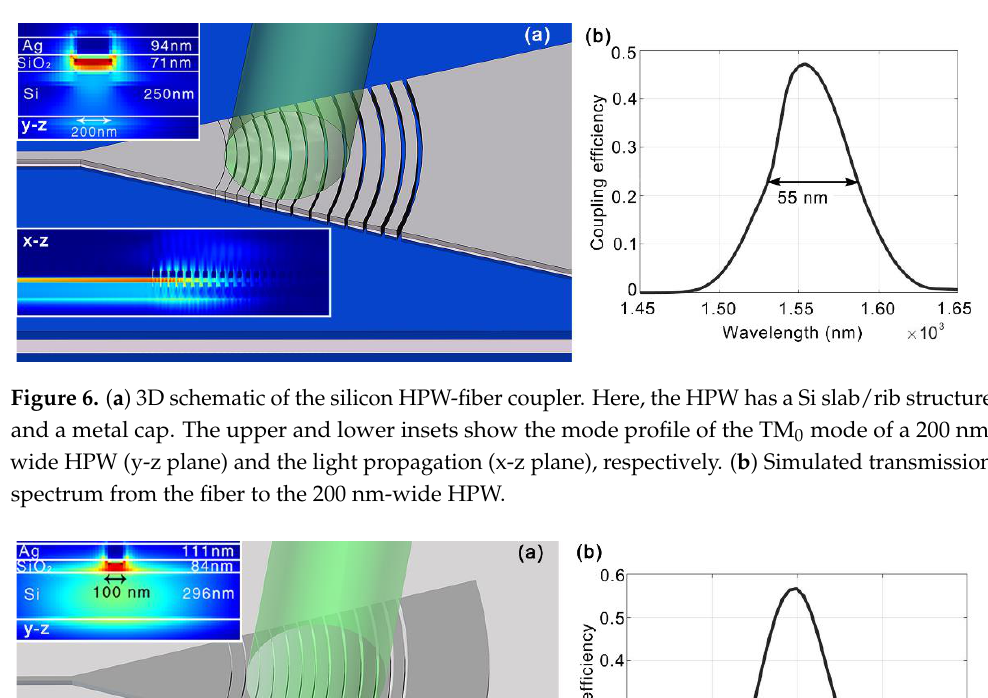
Figure 6. ( a ) 3D schematic of the silicon HPW-fiber coupler. Here, the HPW has a Si slab/rib struc- ture and a metal cap. The upper and lower insets show the mode profile of the TM 0 mode of a 200 nm-wide HPW (y-z plane) and the light propagation (x-z plane), respectively. ( b ) Simulated trans- mission spectrum from the fiber to the 200 nm-wide HPW.